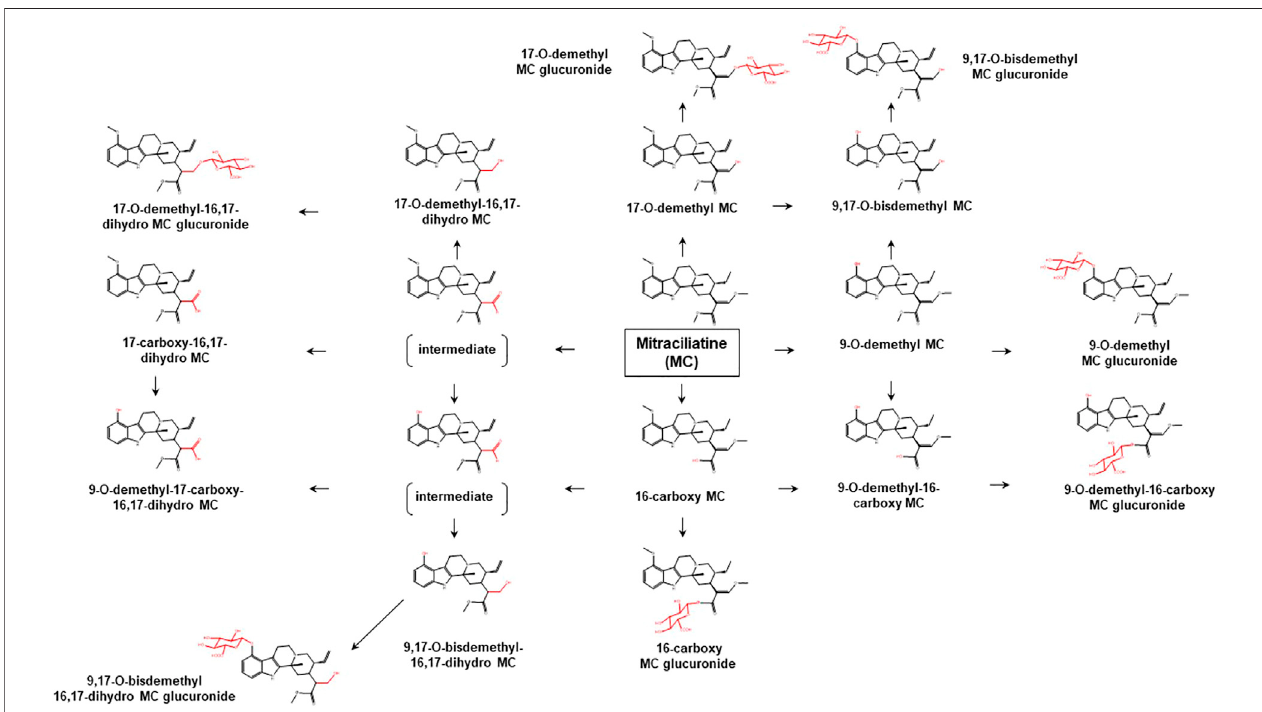
FIGURE 6 | Proposed metabolic pathways of MC based on data obtained in rodents and humans. Structures highlighted in red denote structural transformation from parent molecule MC. Figure was modi fi ed from Philipp et al. (2011b).